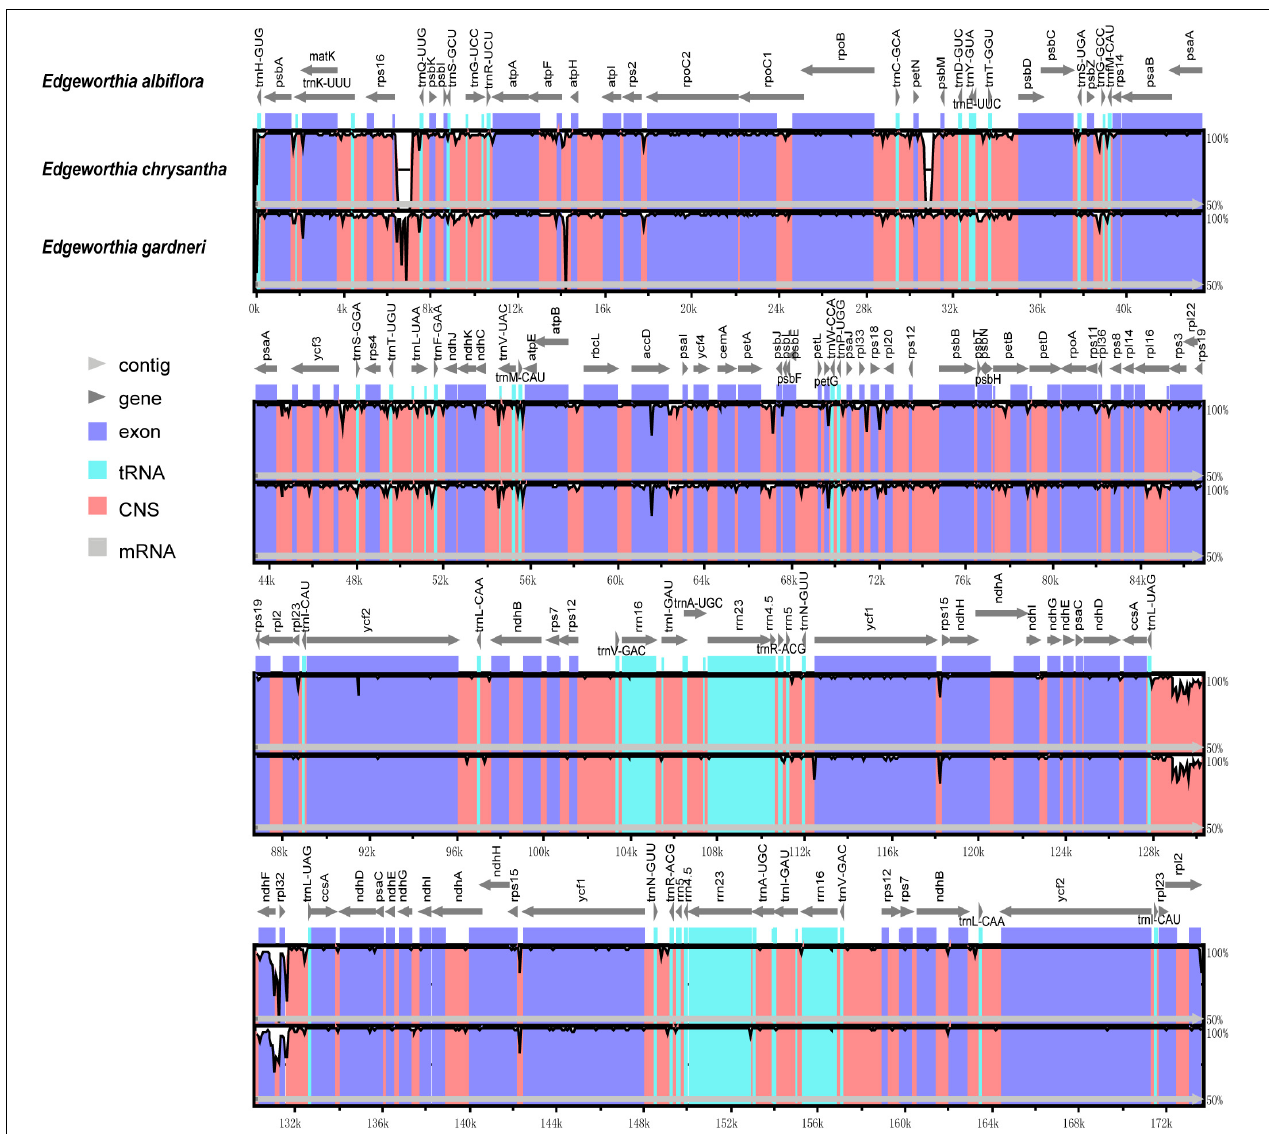
FIGURE 4 | Complete chloroplast genome comparison of three species of Edgeworthia using mVISTA alignment program. Genome regions are color-coded and described in the figure